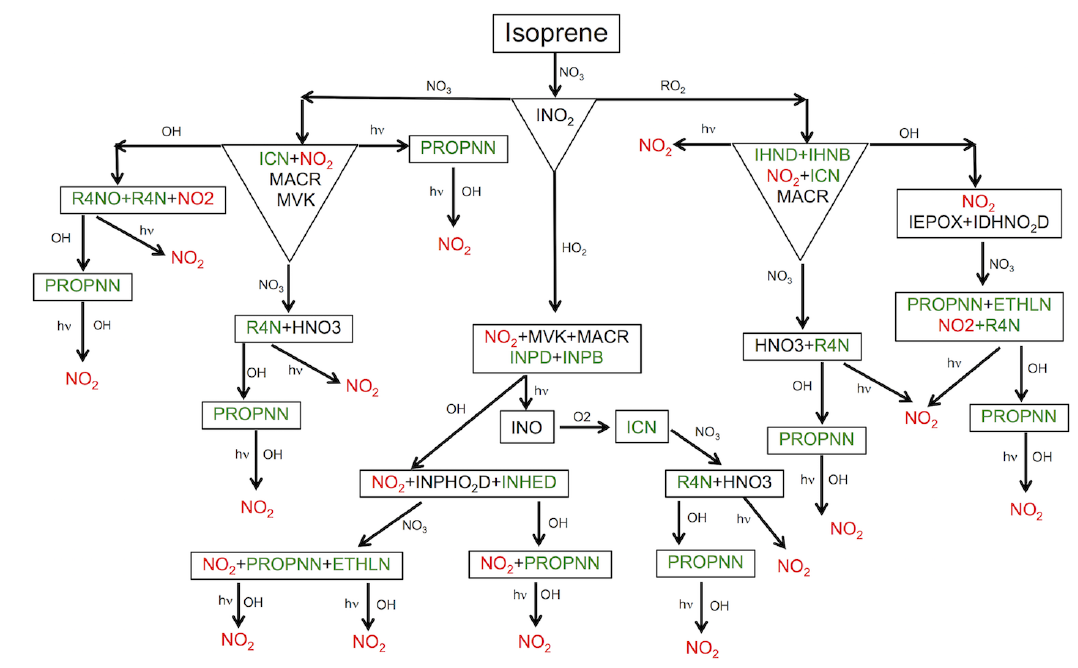
Figure 2. Schematic representation of the formation of isoprene nitrates (in green) initiated by NO 3 oxidation. For simplification, fates of only one isomer of hydroxy nitrates (IHNB and IHND) and nitrooxy hydroperoxide (INPB and INPD) are shown. See Table S2 in the Supplement for species